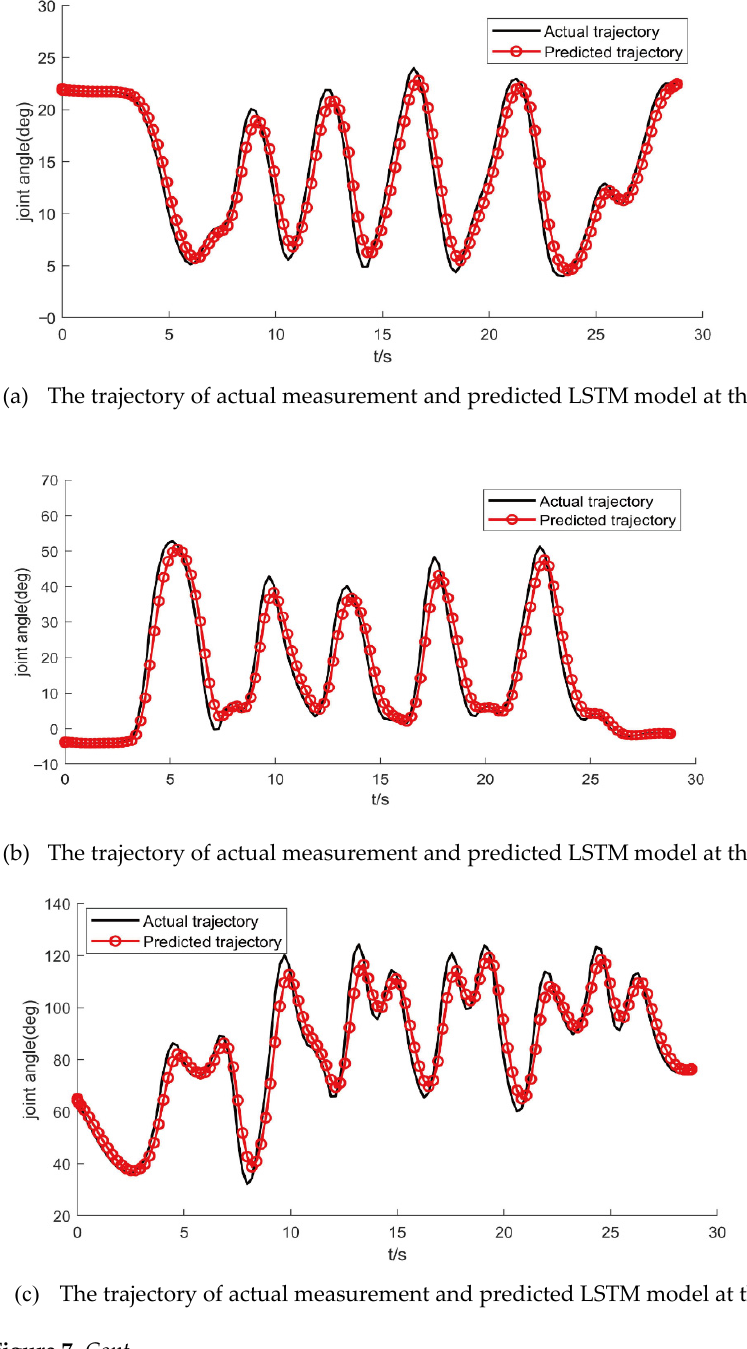
(d) The trajectory of actual measurement and predicted LSTM model at the left hip joint